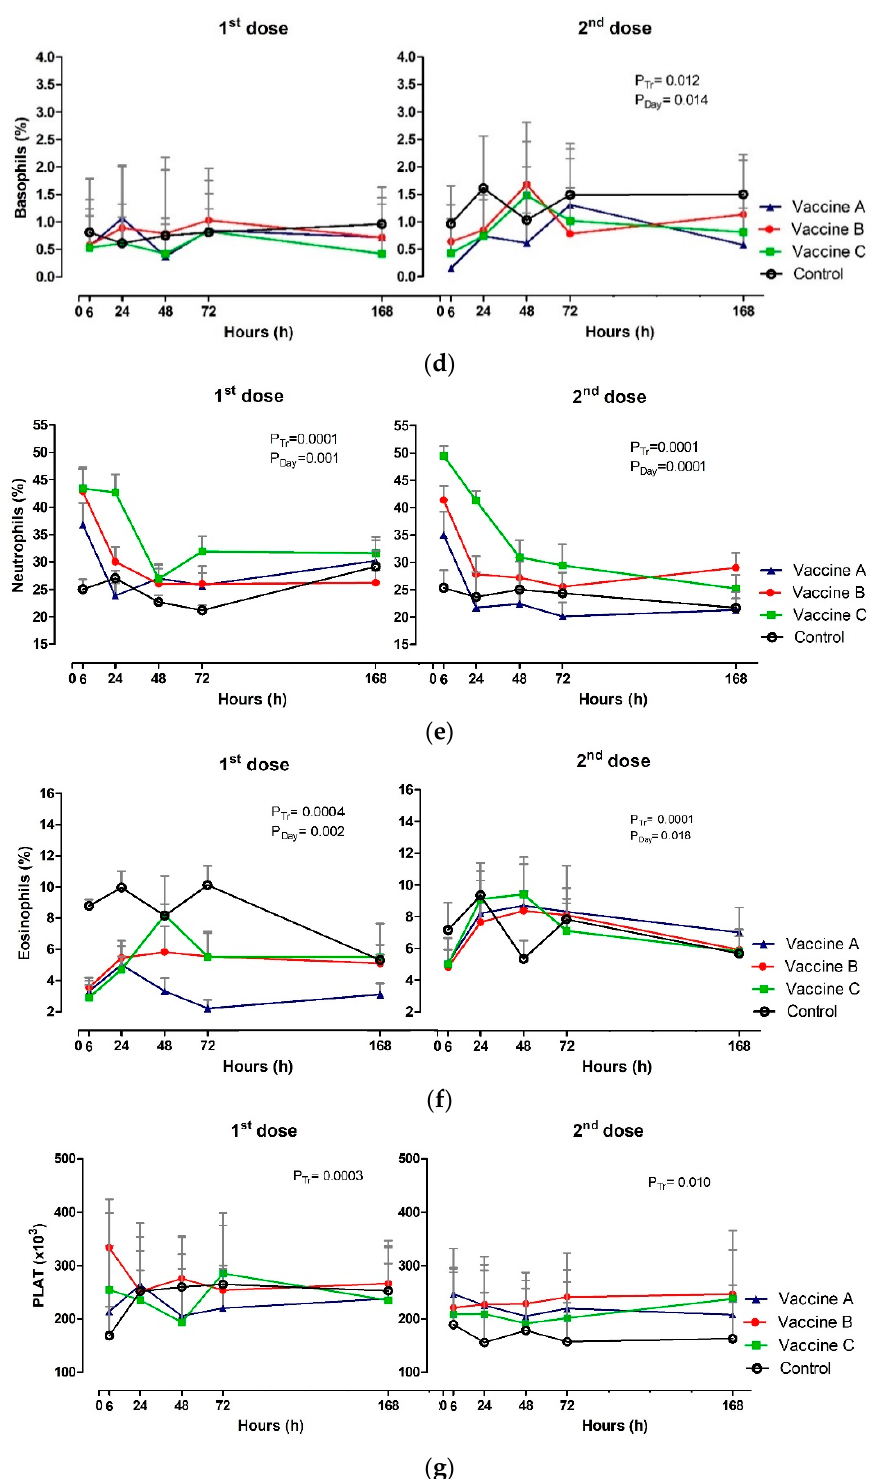
Figure 4. Effect of vaccination on Clinical pathology: ( a ) Total leukocytes (x10 3 /µL); ( b ) lymphocytes (%); ( c ) monocytes (%); ( d ) basophils (%); ( e ) neutrophils; ( f ) eosinophils (%), ( g ) and platelets (x10 3 /µL) in animals vaccinated with three different formulation adjuvanted vaccines against BVDV and BHV-1. Reported are the mean values and standard deviations. Overall statistical significance ( p ≤ 0.05) is indicated in the plot as follows: effects of treatment (P tr ), day (P Day ) and interactions (P tr x P Day ).